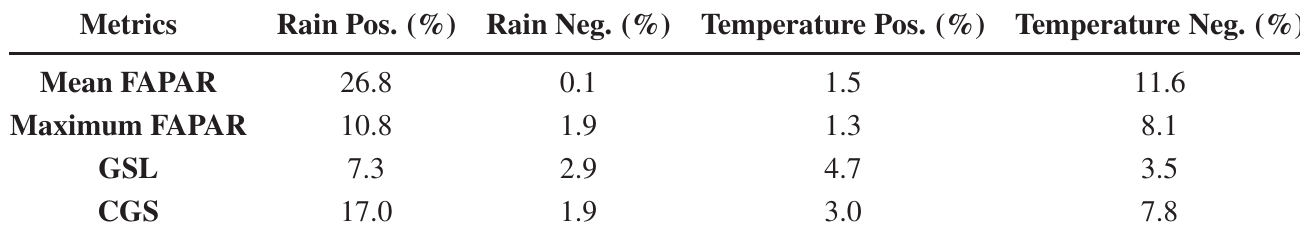
Table 3. Percentage of the study area where the correlation between the annual anomalies of vegetation metrics, temperature and rainfall is significant for positive (pos.) and negative (neg.) correlations